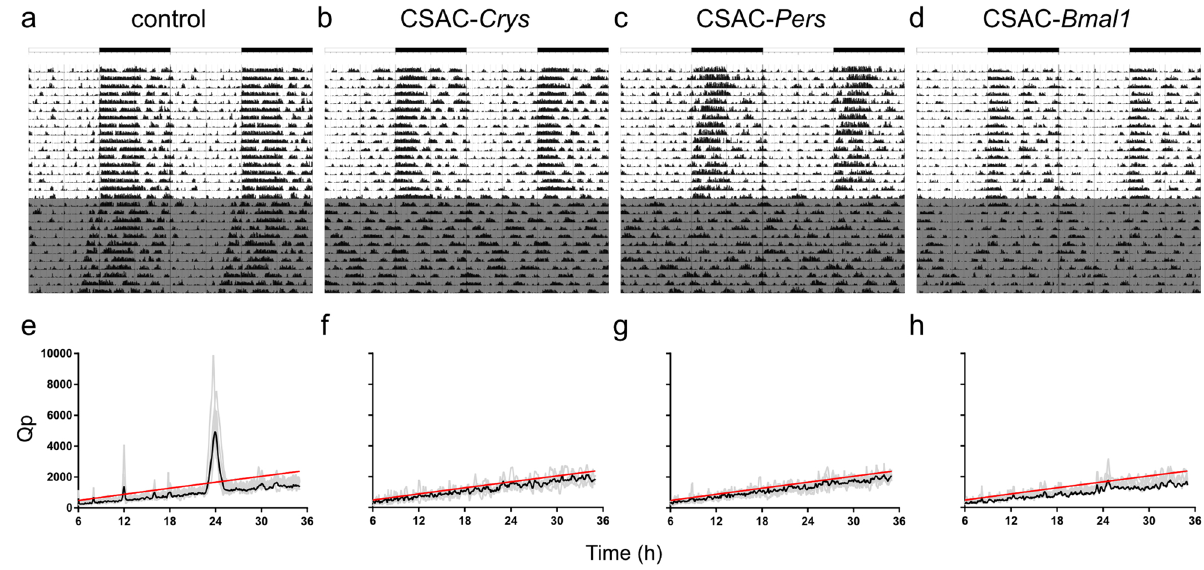
Figure 5. Circadian locomotor activity in SCN-targeted mice. ( a – d ) Representative locomotor pattern displayed as a double plot of activity over 28 d in the control ( a ), CSAC- Crys - ( b ), CSAC- Pers - ( c ), and CSAC- Bmal1 - ( d ) injected mice. Gray indicates periods of constant darkness. ( e – h ) Chi-square periodogram of locomotor activity during constant darkness in control ( e ), CSAC- Crys - ( f ), CSAC- Pers - ( g ), and CSAC- Bmal1 - ( h ) injected mice. Gray indicates the periodogram of an individual mouse. The black line indicates the average spectrogram of each group. The red line indicates the significance threshold ( n = 4–8 mice per group).